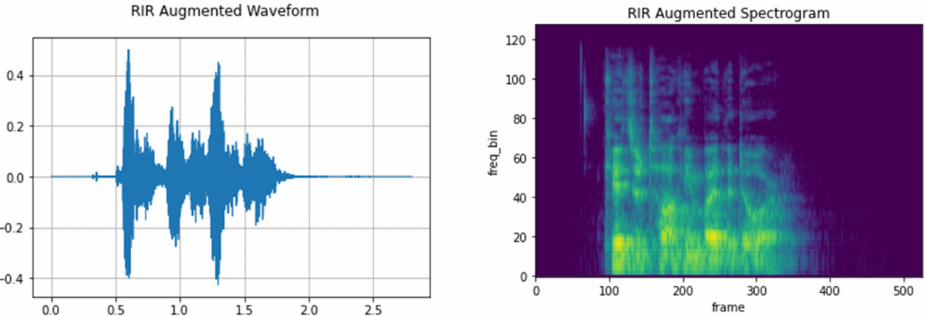
Figure 4. Waveform and Spectrogram representations of a Room Impulse Response augmented sample.